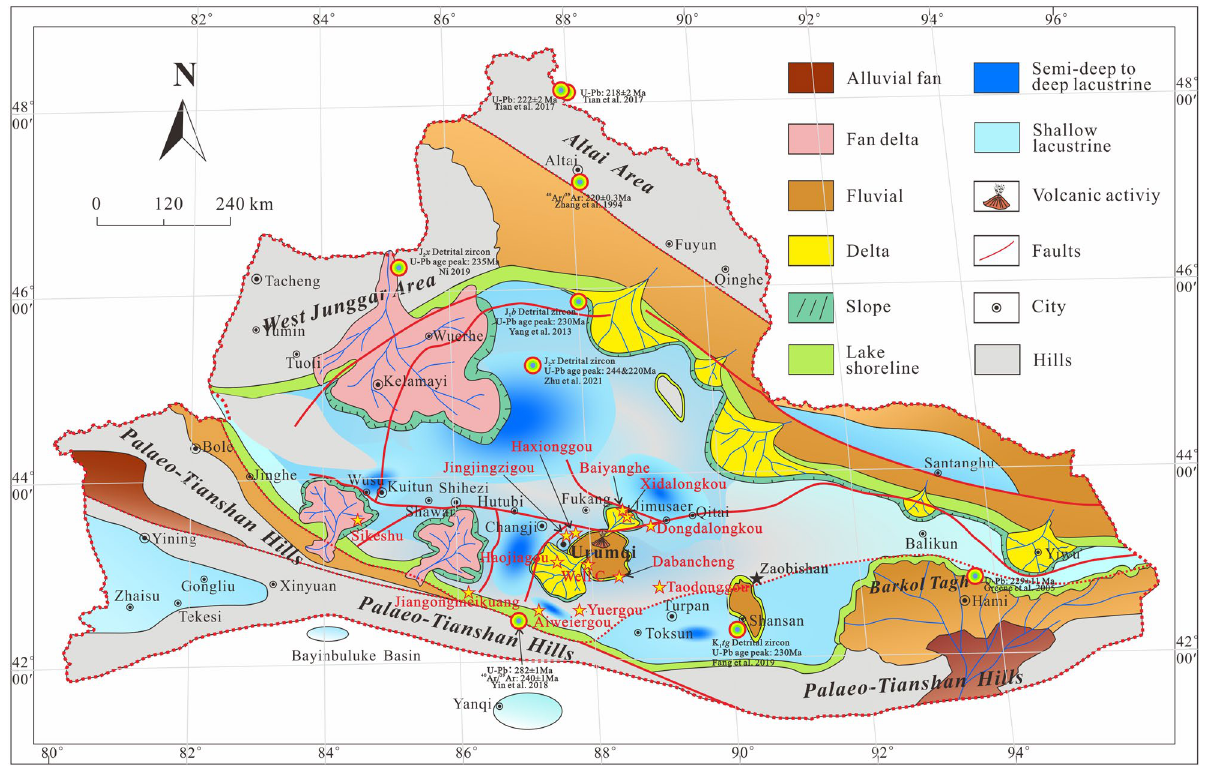
Figure 2. Paleogeographic map of the Junggar Basin and adjacent areas during the Middle–Late Triassic